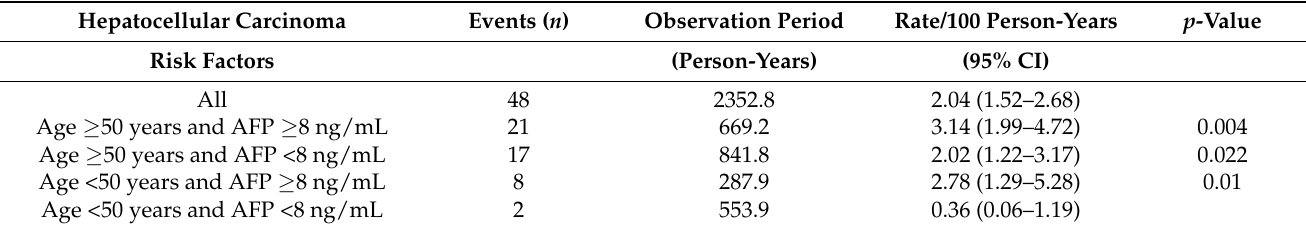
Table 3. Incidence rates of hepatocellular carcinoma stratified according to risk factors.